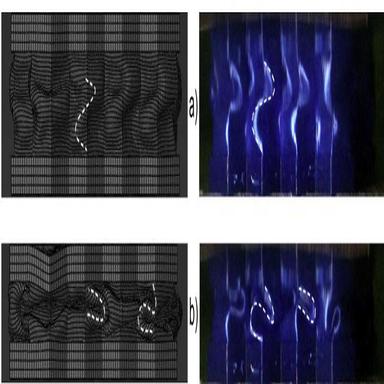
CT scanned cross-sections of cuboid geometry. Left-right: bottom, centre, top.